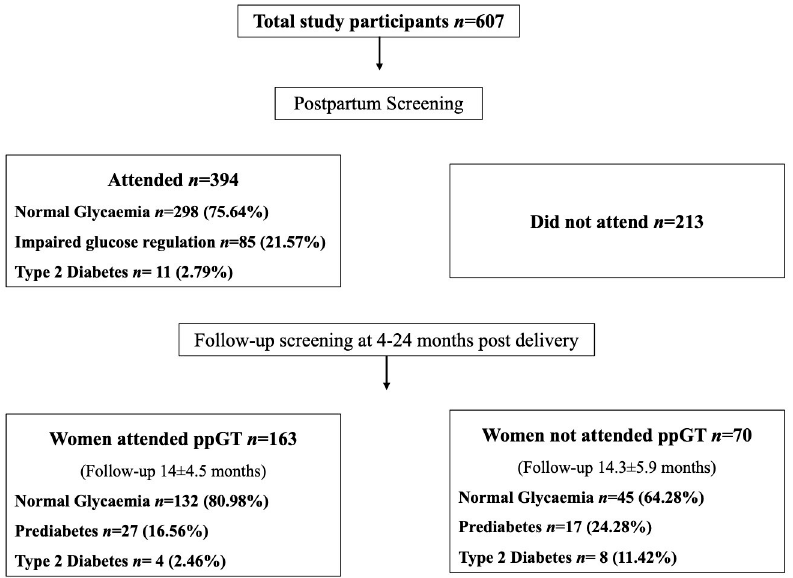
Fig 1. Consort diagram of immediate postpartum glucose testing attendance and follow-up for 24-months post- delivery. The flow chart displayed the proportion of GDM women attended vs not attended ppGT. The diagnosis of dysglycaemia/impaired glucose regulation and Type 2 diabetes was performed as, Normal glycaemia: FPG < 5.6 and 2-hr glucose < 7.8 at postpartum OGTT or HbA1c < 39 mmol/mol ( < 5.7%); Impaired glucose regulation: IFG, IGT and/or Prediabetes [Impaired Fasting glucose: FPG � 5.6mmol/L; Impaired Glucose tolerance: 2-hr glucose � 7.8 mmol/L; Prediabetes: HbA1c � 39 to < 48 mmol/mol ( � 5.7 and < 6.4%)]; Type 2 diabetes: FPG � 7.0mmol/L and/or 2-hr � 11.1mmol/L post 75g OGTT or HbA1c � 48mmol/mol ( � 6.5%).